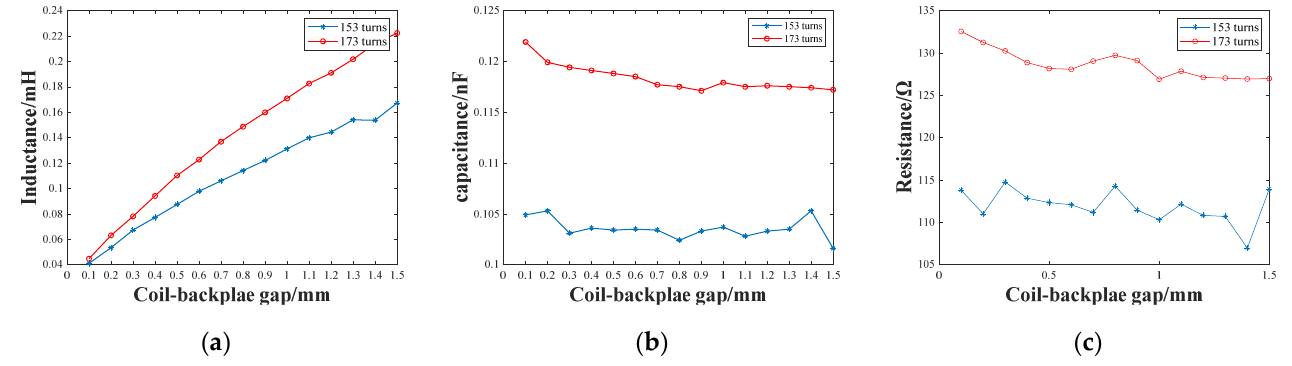
Figure 9. The total ( a ) resistance, ( b ) inductance, and ( c ) capacitance parameters of receiving coils, with the backplate at a different distance.